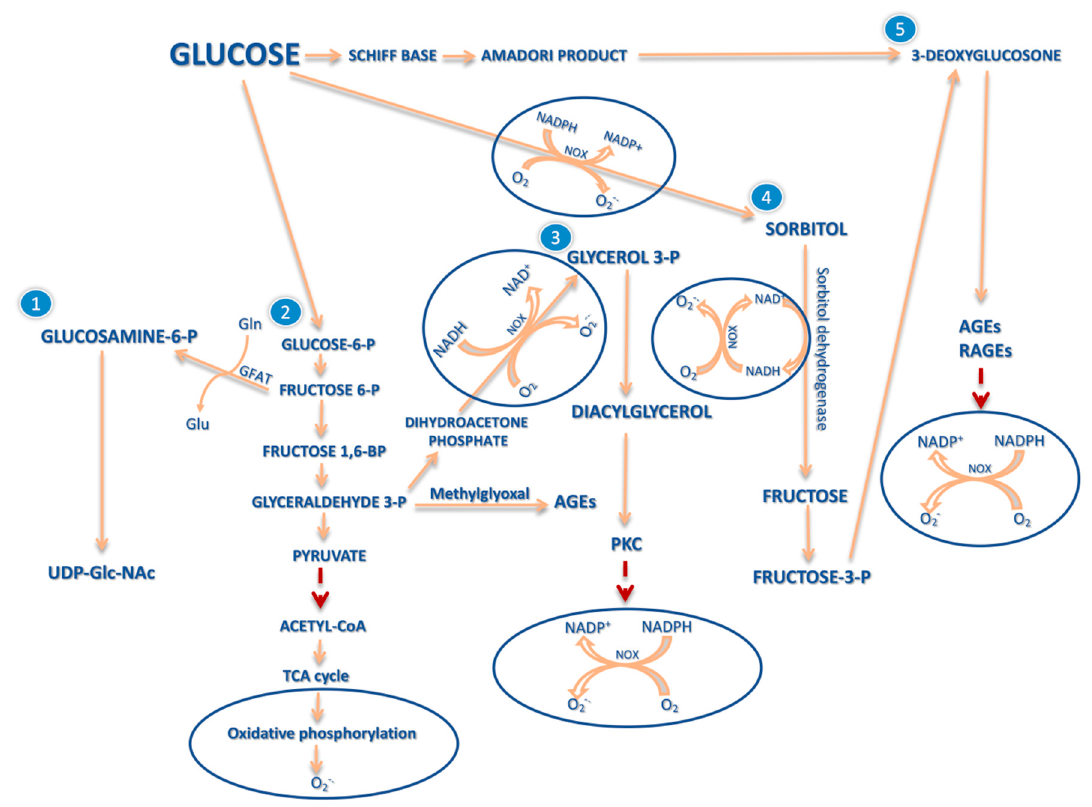
Figure 1. Activation of alternative pathways for glucose metabolism [27]. In a hyperglycemic state, alternative glucose pathways are activated. A higher than normal level of glucose can induce polyol (4), hexoamine (1) and PKC pathways (3), increase basic glycolysis (2), as well as enhance AGEs production (5). Acetyl coenzyme A ( Acetyl-Coa ), advanced glycation end products ( AGEs ), glutamine ( Gln ), glutamic acid ( Glu ), glutamine:fructose-6-phosphate amidotransferase ( GFAT ), NAD(P)H oxidase ( NOX ), nicotinoamide adenine dinucleotide ( NAD + / NADH ), protein kinase C ( PKC ), receptors for advanced glycation end products ( RAGEs ), superoxide radical ( O2 •− ), tricarboxylic acid cycle ( TCA cycle ), uridine diphosphate N-acetylglucosamine ( UDP-Glc-NAc ).